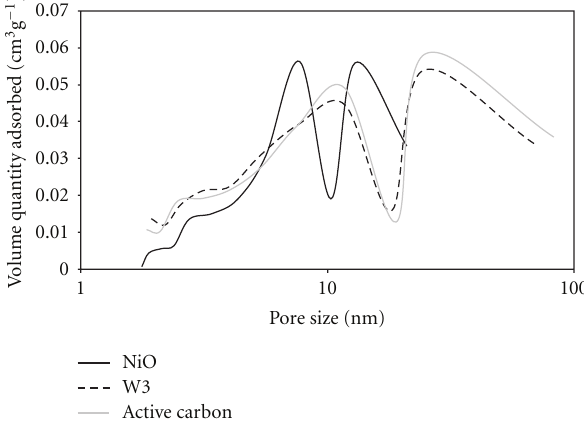
Figure 4: Nitrogen absorption/desorption isotherms of NiO, composite W3, and active carbon at 77 K.